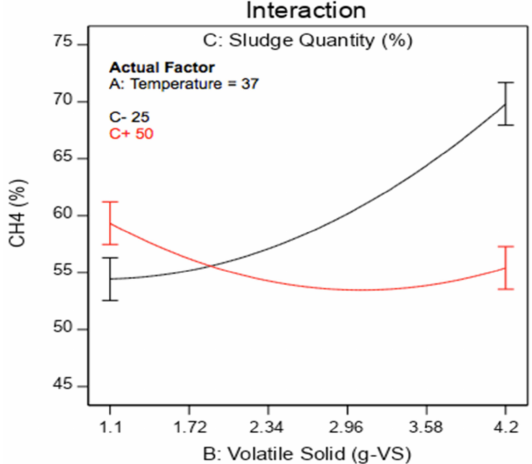
Figure 30. Interaction Plot illustrates the effect of interaction between volatile solid and sludge quantity on CH 4 percentage.